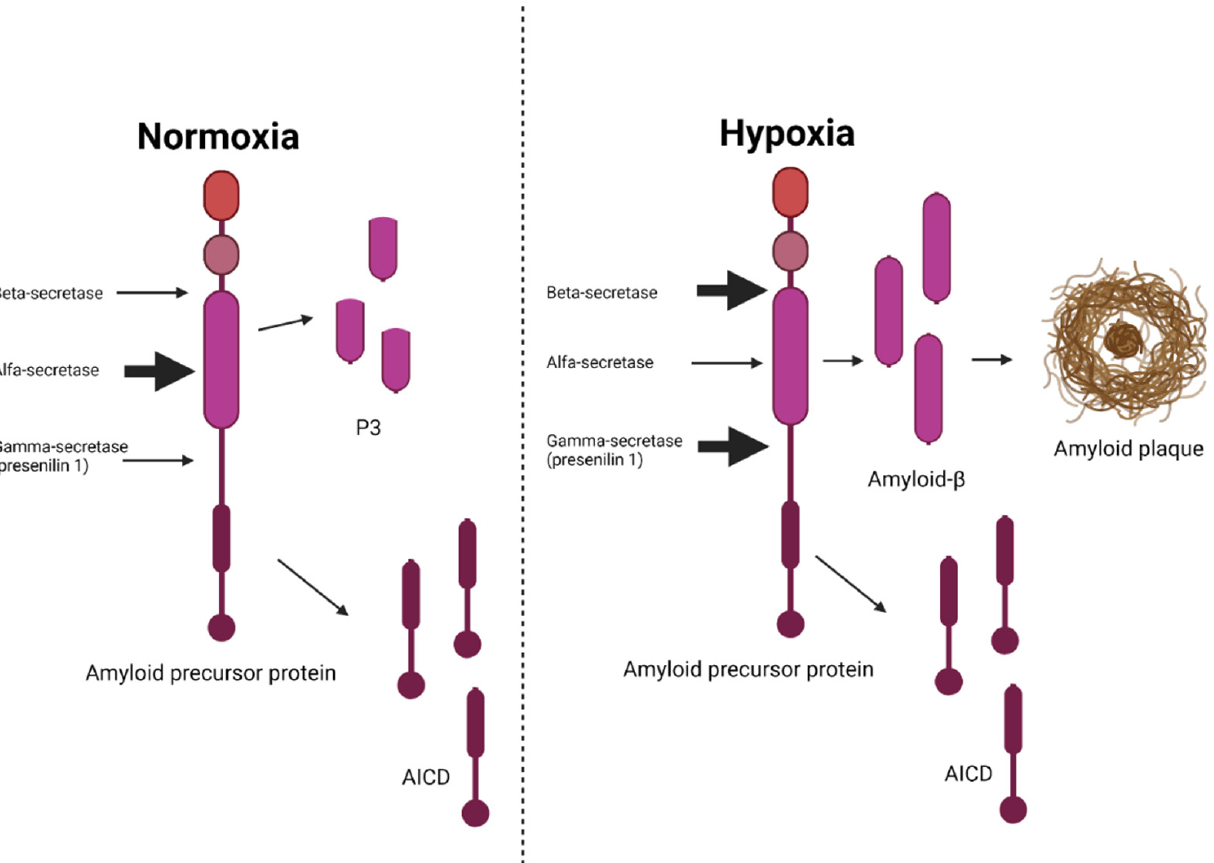
Figure 7. The impact of hypoxia/ischemia on the processing of amyloid precursor protein. During normoxia, the alfa-secretase is more active than the beta- and gamma-secretases resulting in very little production of β -amyloid. During hypoxia, the beta- and gamma-secretases are stimulated causing an excess production of β -amyloid leading to the formation of amyloid plaques—a pathological hallmark of Alzheimer’s disease. AICD, amyloid precursor protein intracellular domain. Adapted from Salminen et al., J. Neurochem 2017 [23]. Created with Biorender.com.